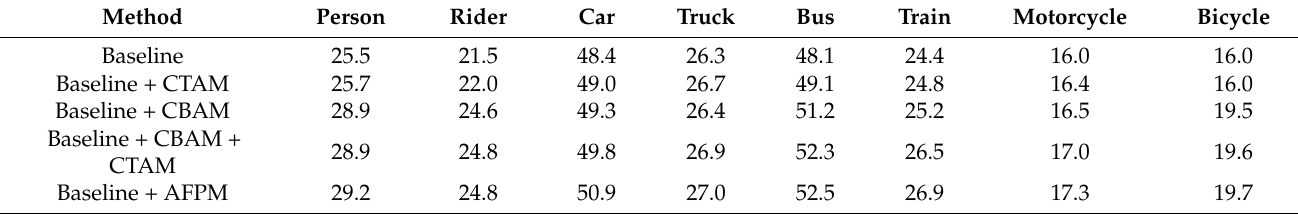
Table 5. Comparison of AP (%) for each instance class on the Cityscapes validation